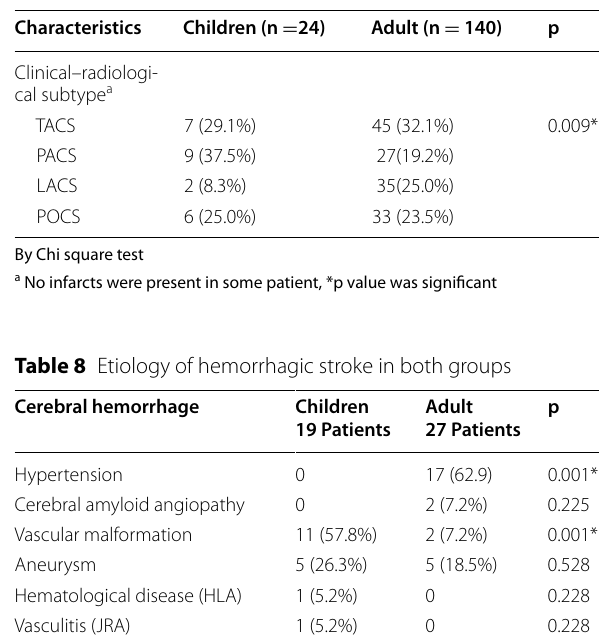
Table 7 Clinico‑radiological ischemic stroke subtypes in both groups (OCSP classification)